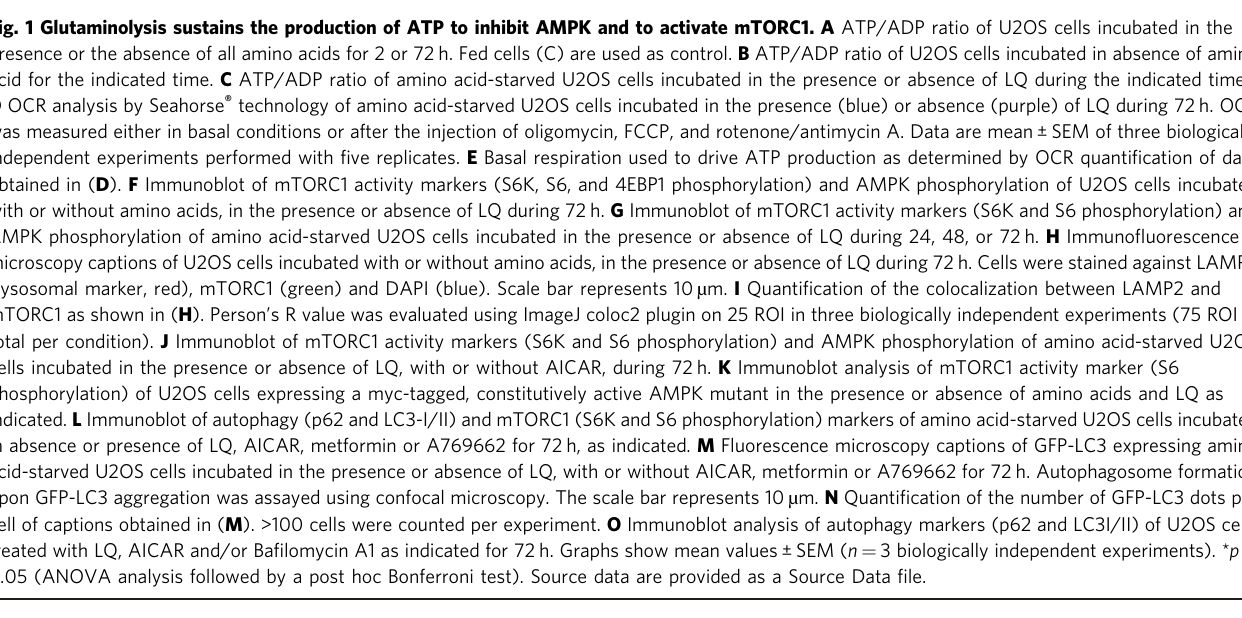
Fig. 1 Glutaminolysis sustains the production of ATP to inhibit AMPK and to activate mTORC1. A ATP/ADP ratio of U2OS cells incubated in the presence or the absence of all amino acids for 2 or 72 h. Fed cells (C) are used as control. B ATP/ADP ratio of U2OS cells incubated in absence of amino acid for the indicated time. C ATP/ADP ratio of amino acid-starved U2OS cells incubated in the presence or absence of LQ during the indicated times. D OCR analysis by Seahorse ® technology of amino acid-starved U2OS cells incubated in the presence (blue) or absence (purple) of LQ during 72 h. OCR was measured either in basal conditions or after the injection of oligomycin, FCCP, and rotenone/antimycin A. Data are mean ± SEM of three